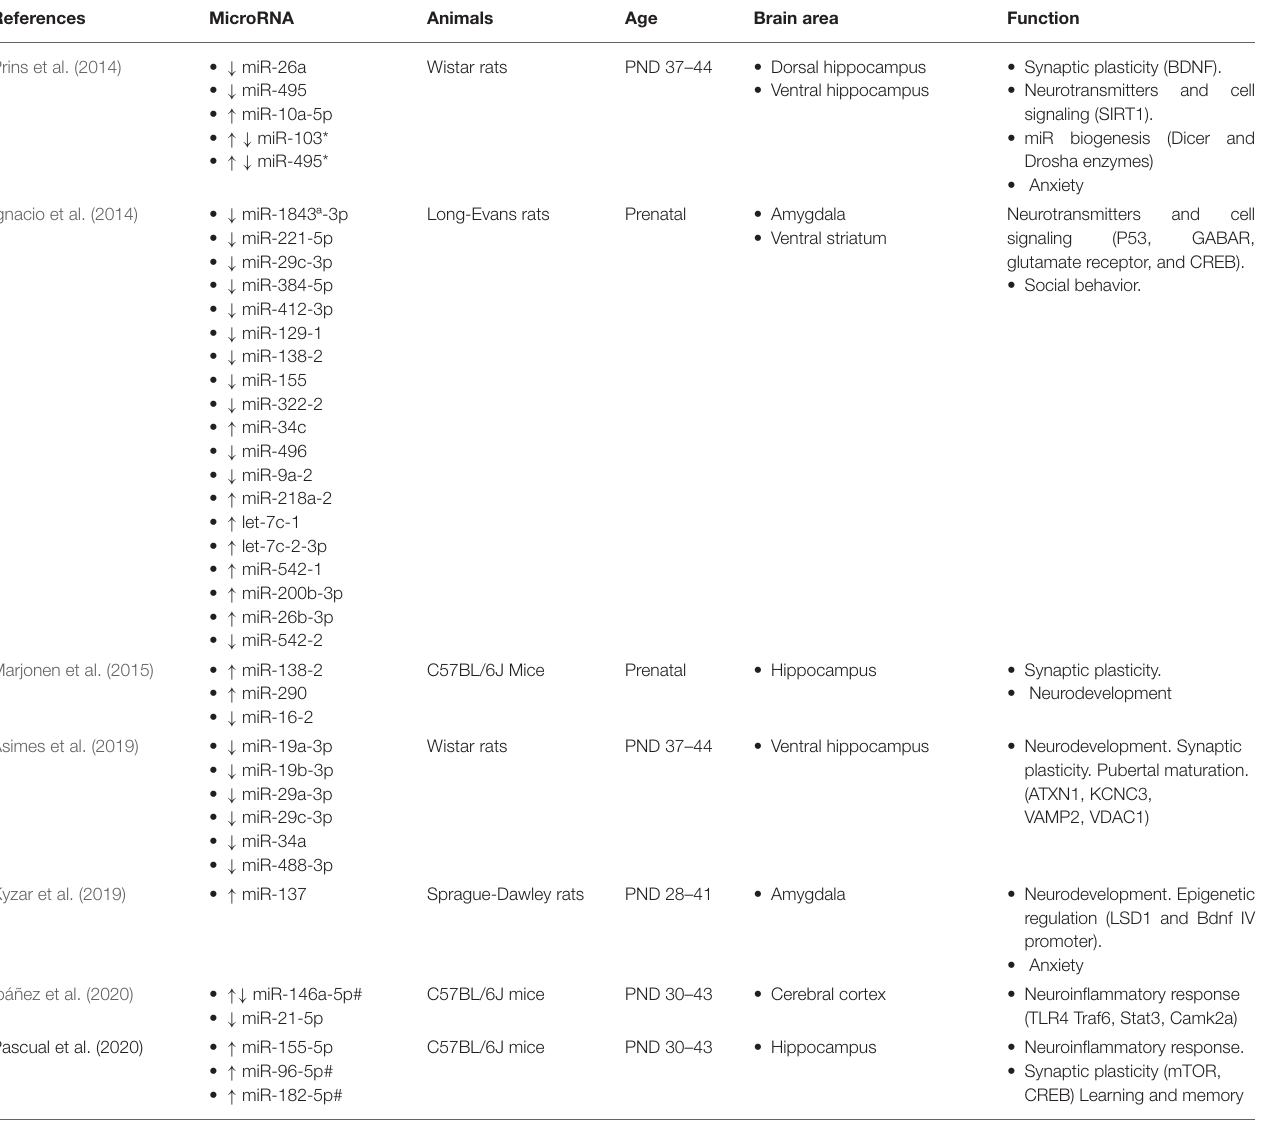
TABLE 1 | Effect of ethanol exposure on brain miRNA expression and